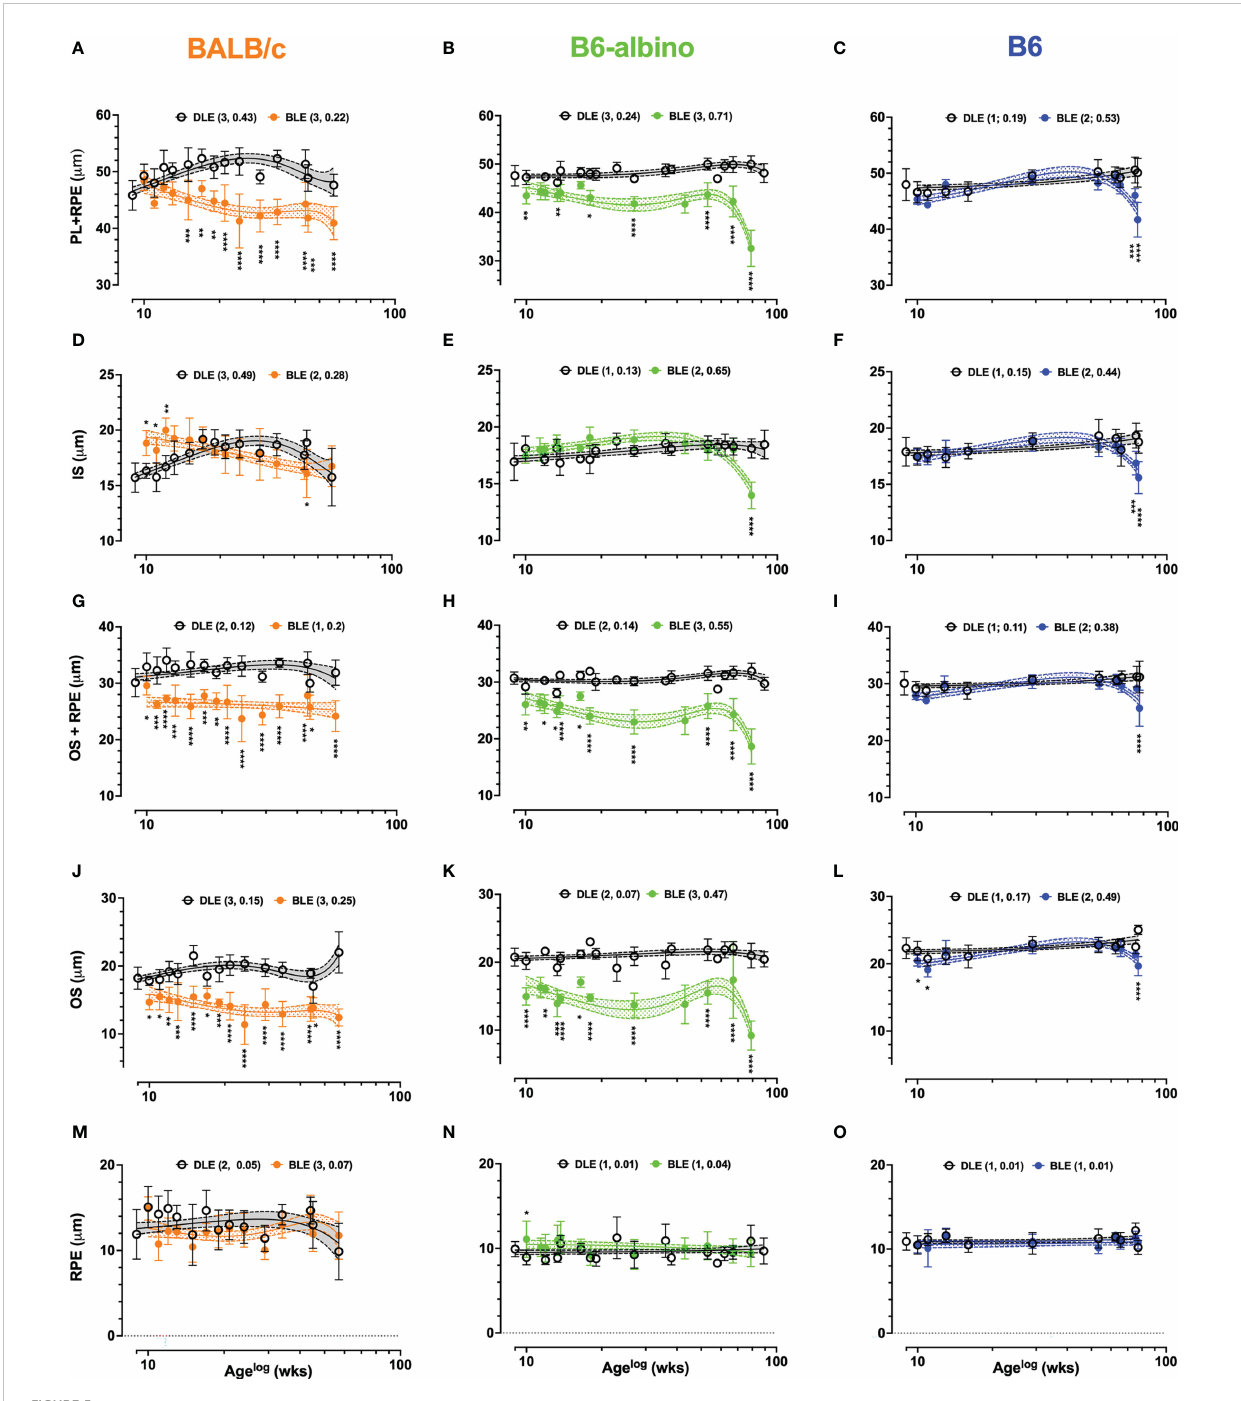
FIGURE 5 Dynamic trends in lamina thicknesses measured and extracted from LRP data in BALB/c (A, D, G, J, M) B6-albino (B, E, H, K, N) and B6 (C, F, I, L, O) mouse strains. Each graph shows long-term trends comparing DLE and BLE groups for PL+RPE (Analysis #7; A – C ), IS (Analysis #7a; (D – F) , OS+RPE (Analysis #7b; G – I ), OS (Analysis 7b.1; J – L ) and RPE (Analysis #7b.2; M – O ). Datapoints show mean+/-SD and curve fi t are mean+/-95% CI. Legends indicate the curve fi t polynomial order and R-squared in parenthesis for both DLE and BLE